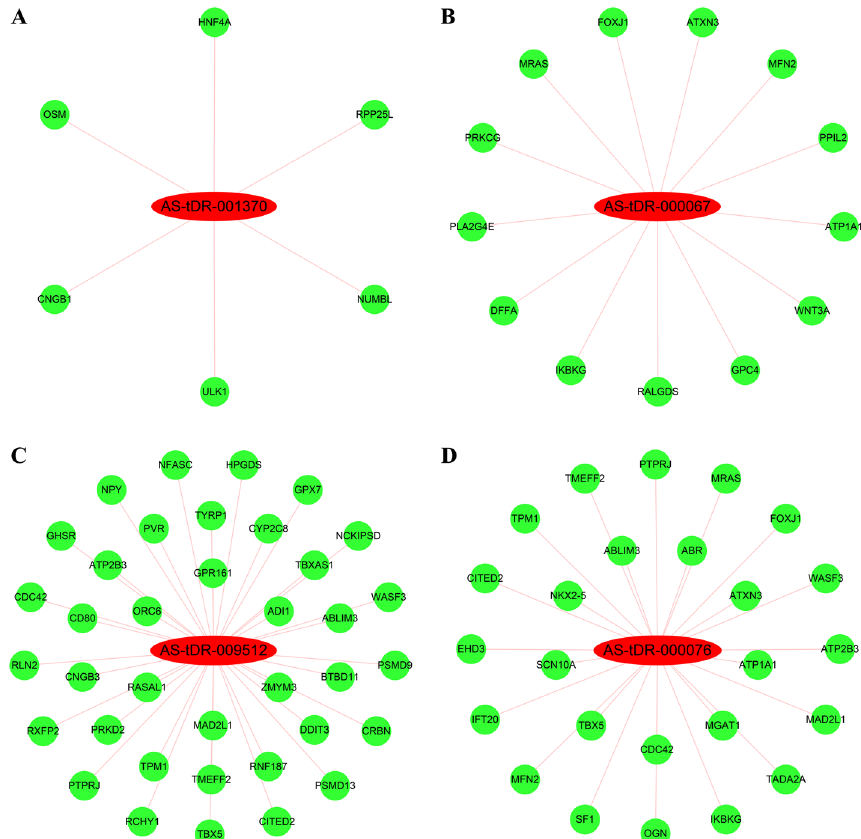
Fig. 3 Construction of tsRNA–mRNA interaction networks. Subnetworks of A AS‑tDR‑001370, B AS‑tDR‑000067, C AS‑tDR‑009512, and D AS‑tDR‑000076. Red nodes indicate increased DEtsRNAs, while green nodes indicate proliferation‑related decreased target